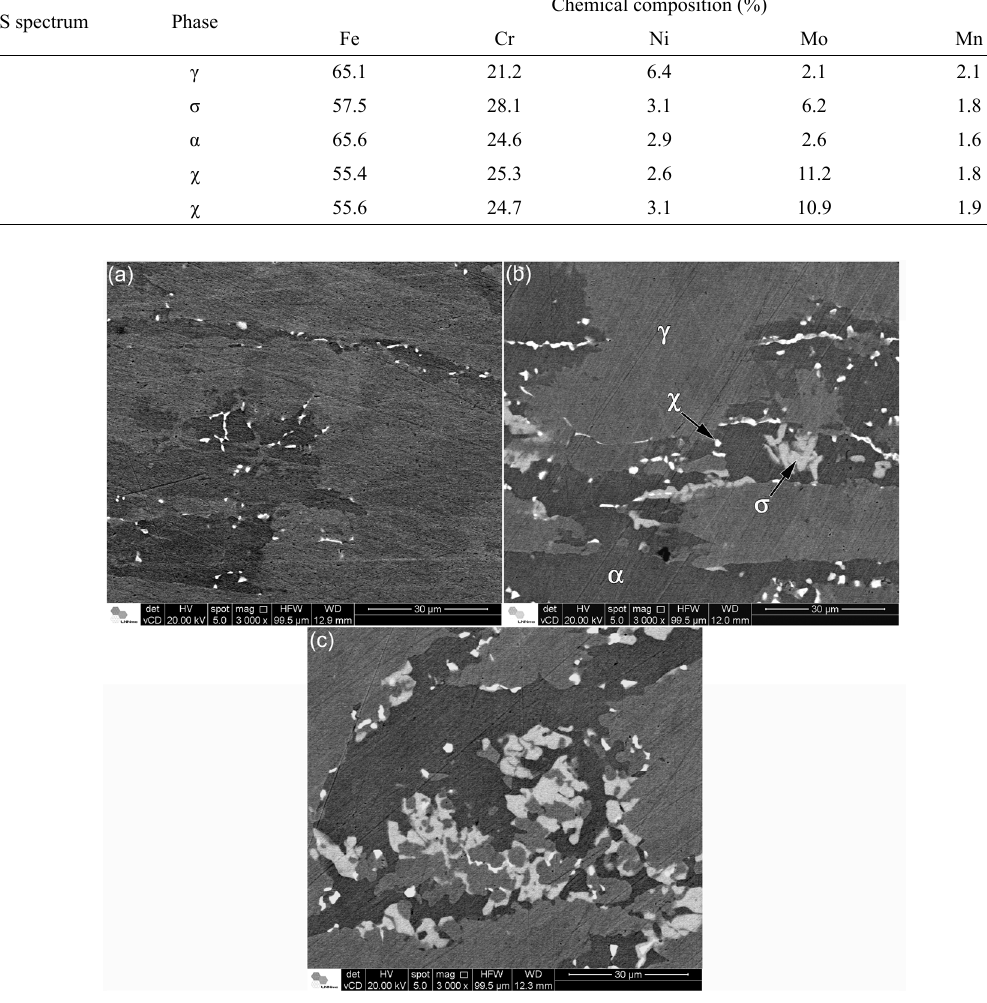
Figure 4. Non-etched micrographs obtained using the SEM backscattered electron signal for different durations of isothermal heat treatment at 850 ºC. (a) 10 minutes, (b) 30 minutes, (c) 60